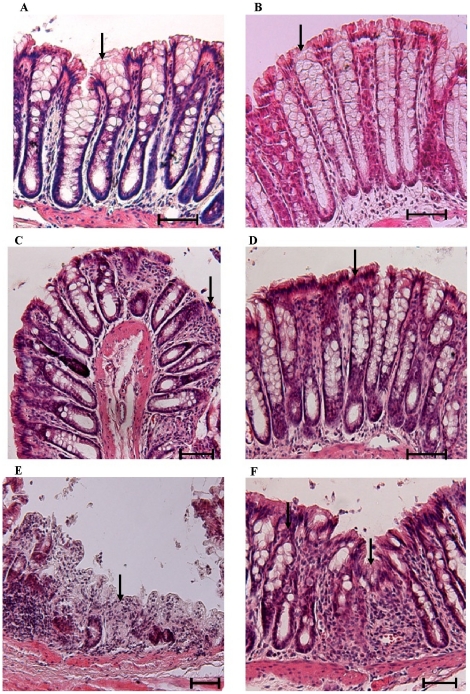
The effect of TNF-α neutralizing antibody on the development of colonic lesions in DSS treated rats.A: DSS treatment alone on day 2 showing intact mucosal (arrow) and sub-mucosal structures. B: TNF-α neutralizing antibody plus DSS treatment on day 2 showing intact crypts and mucosal (arrow) and submucosal structure. C: DSS treatment alone on day 5 showing focal erosions of the epithelium (arrow) with acute inflammatory infiltrate. D: The effect of TNF-α neutralizing antibody plus DSS treatment on day 5 showing well developed crypts with no abnormal cellular infiltrate with intact mucosa (arrow). E: DSS treatment alone on day 9 showing extensive mucosal damage and deep ulceration (arrow) with large numbers of inflammatory cellular infiltrates. F: The effect of TNF-α neutralizing antibody plus DSS treatment on day 9 showing focal erosions (arrow) with less damaged and cellular infiltrate in the mucosal architecture adjacent to the lesion. (All sections were stained with H&E; scale bar represents 25 µm).